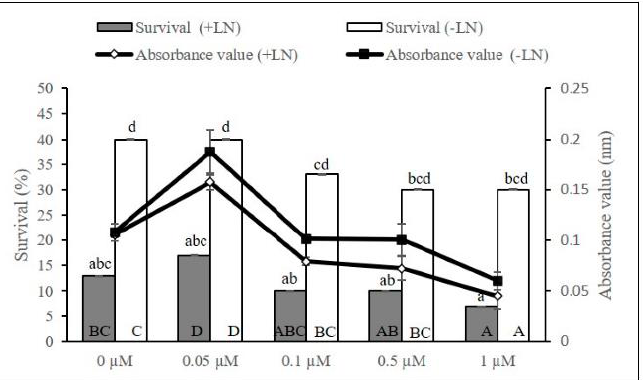
Figure 4. Effect of exogenous melatonin concentration on the viability of cryopreserved (+LN) and non-cryopreserved ( − LN) axillary buds during the growth recovery stage. Error bars represent standard errors. Means with different letters (upper case: Absorbance; lower case: Survival) are significantly different based on Duncan Multiple Range Test (DMRT) at p ≤